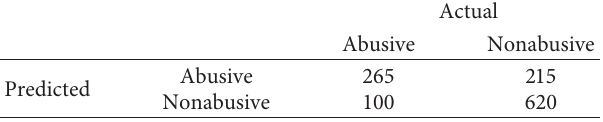
Table 3: Confusion matrix.